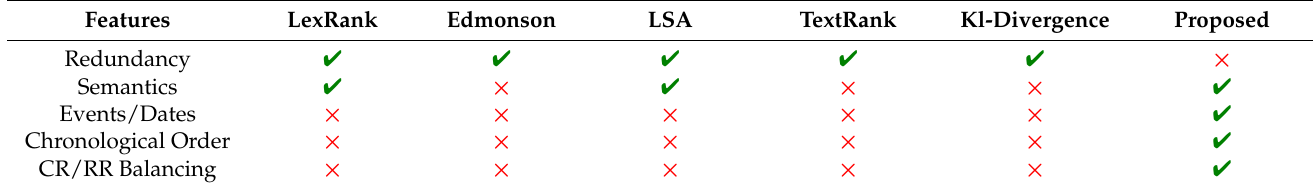
Table 1. Comparison of algorithms based on their